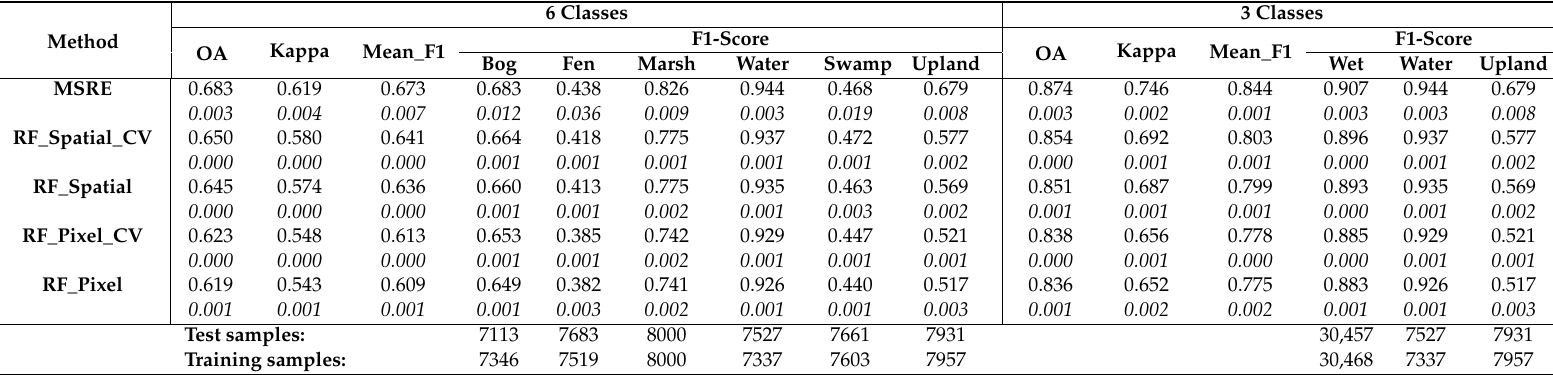
Table 2. AMWI results including May and October composites for the spatial extension assessment and hold-out training convergence. 6 Classes 3